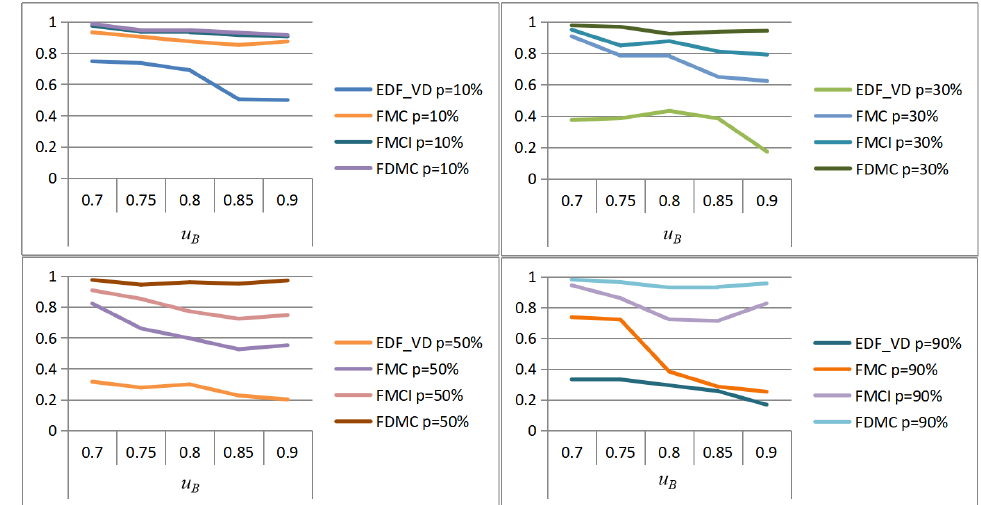
Figure 8. The PFJ comparison of different schemes under the same p